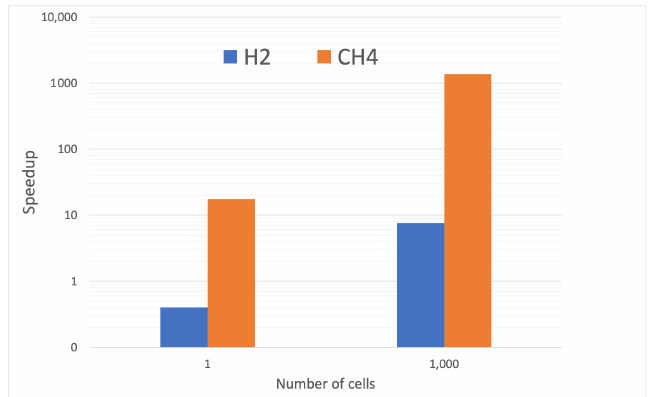
Figure 10. Observed speedup from applying LIT for H 2 –O 2 and CH 4 –O 2 combustion with reference to the OpenFOAM ODE